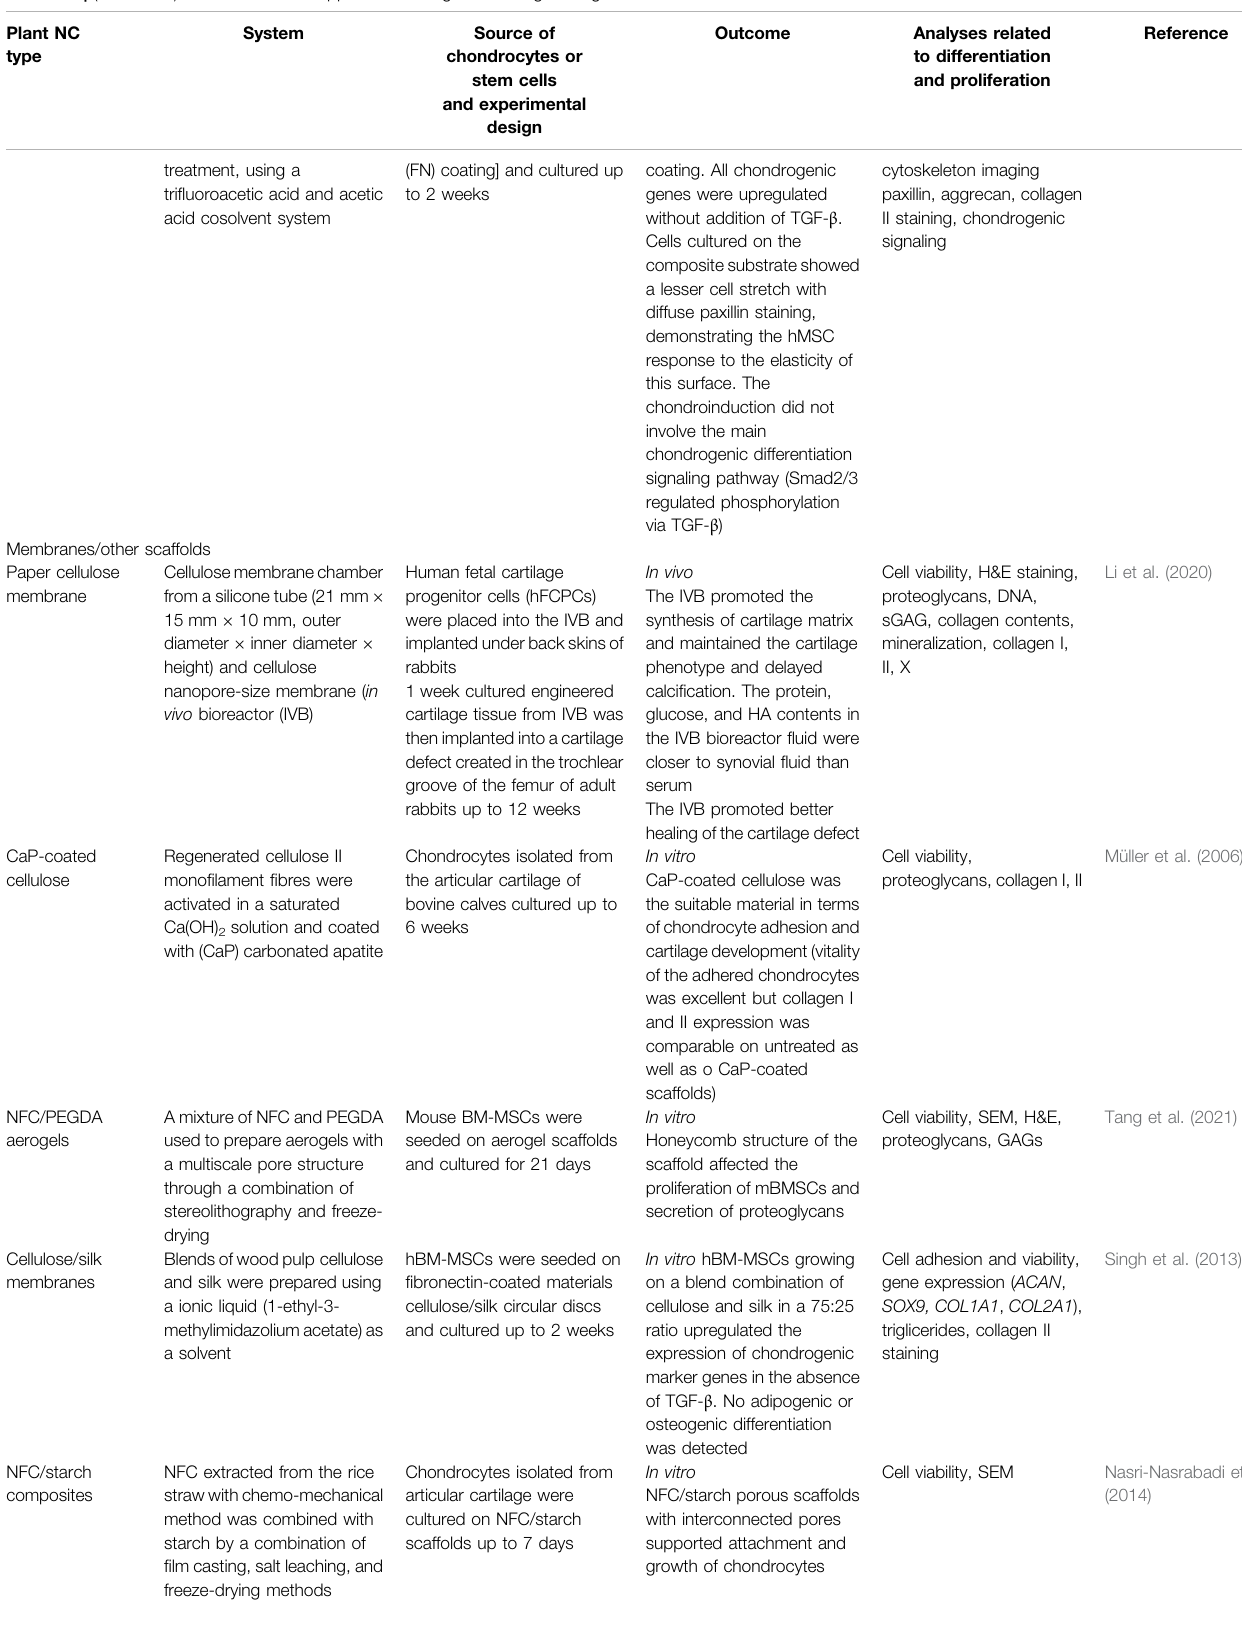
TABLE 1 | ( Continued ) Plant-derived NC applied to cartilage tissue